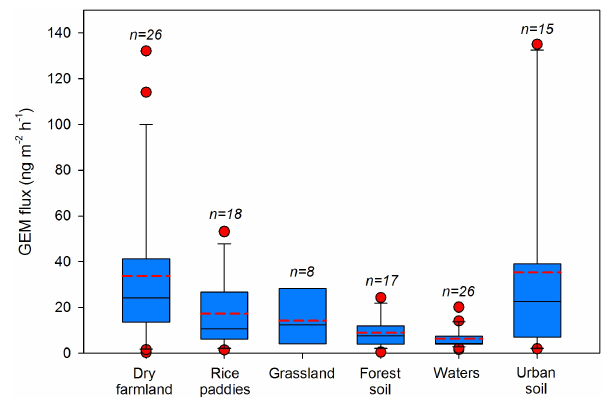
Figure 7. Statistical summary of GEM emission fluxes from typical landscapes in China in warm seasons (from May to October). The solid lines within each box represent the median fluxes, the dashed lines represent the mean, boundaries of the boxes represent 25th and 75th percentiles, whiskers indicate 10th and 90th percentiles, and red circles indicate fluxes <10th percentile or >90th